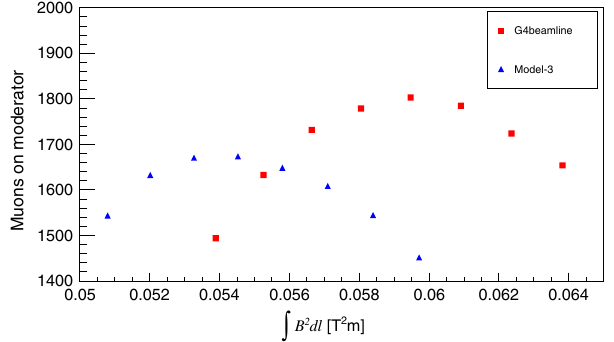
FIG. 20. Comparison of focusing capabilities of model-3 WSY and G4beamline solenoid by using OTE in the simulation. Red squares show the number of muons on the moderator for the G4beamline solenoid as a function of focusing power (max ¼ 1803 muons). Blue triangles show the result for model-3 WSY (max ¼ 1685 muons).